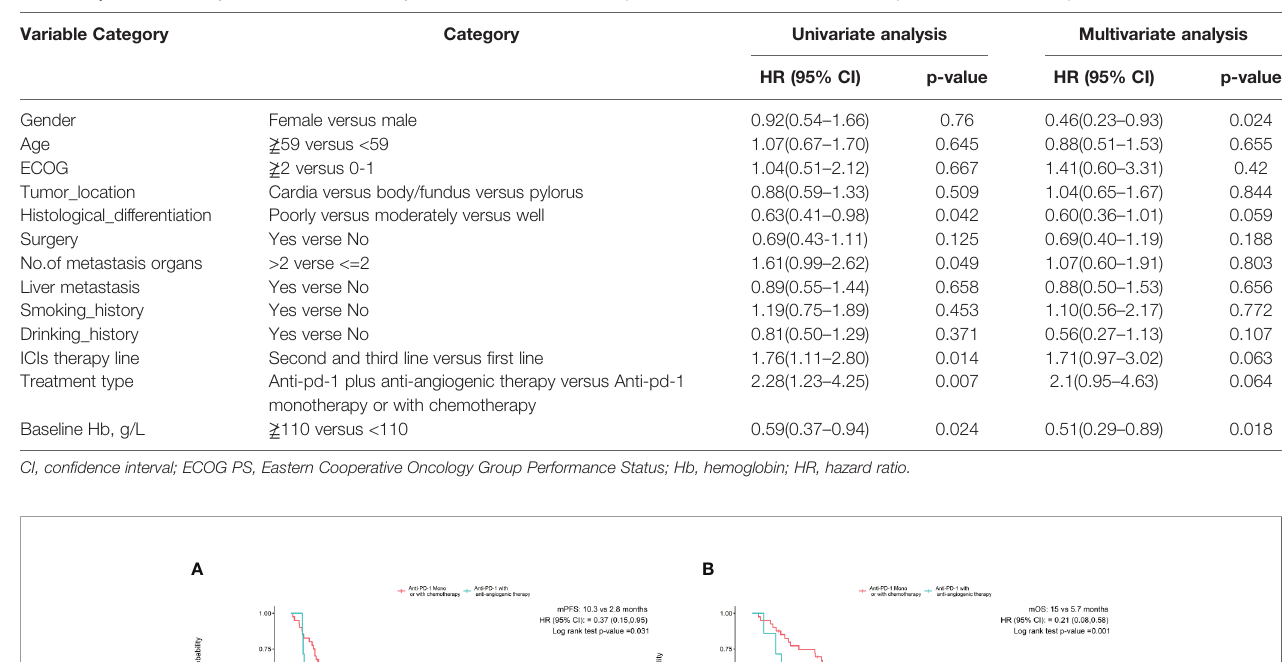
TABLE 4 | Univariate analysis and multivariate analysis of clinical variable for the prediction of overall survival of AGC patients treat with anti-pd-1